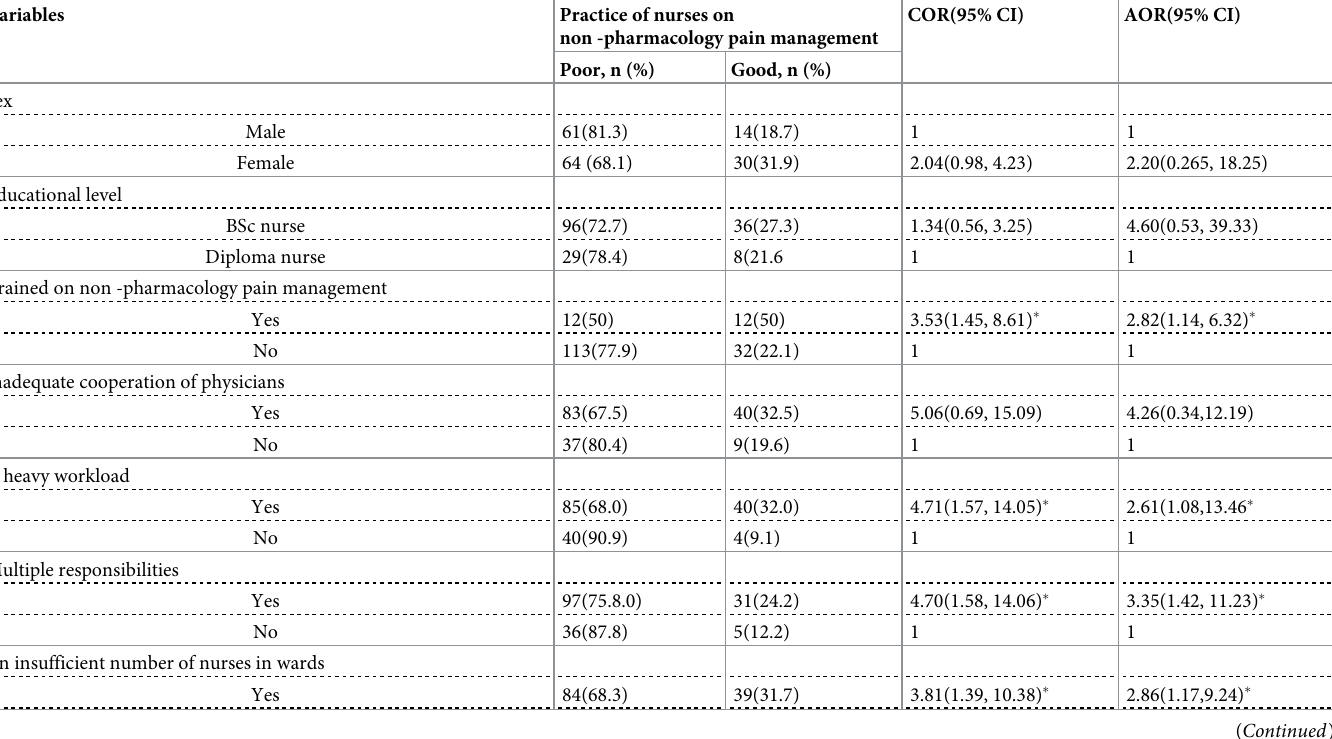
Table 4. Logistic regression analysis for practice of nurses’ on non-pharmacological pain management in Debre Tabor Comprehensive Specialized Hospital, Ethio- pia, 2020.